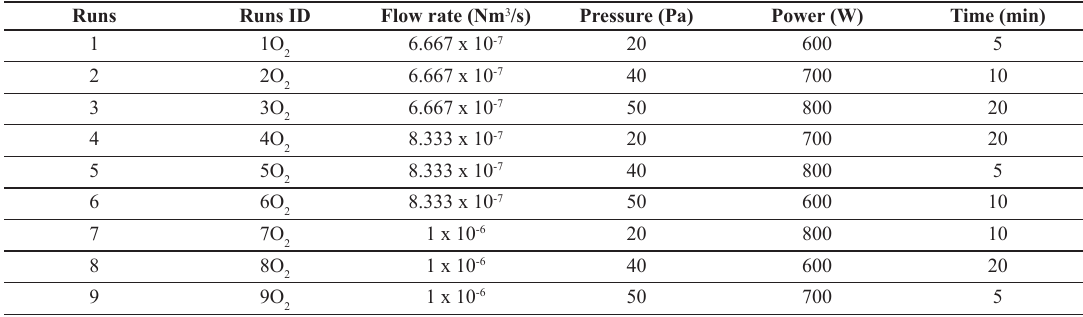
) plasma with 4 factors and 3 levels. 2